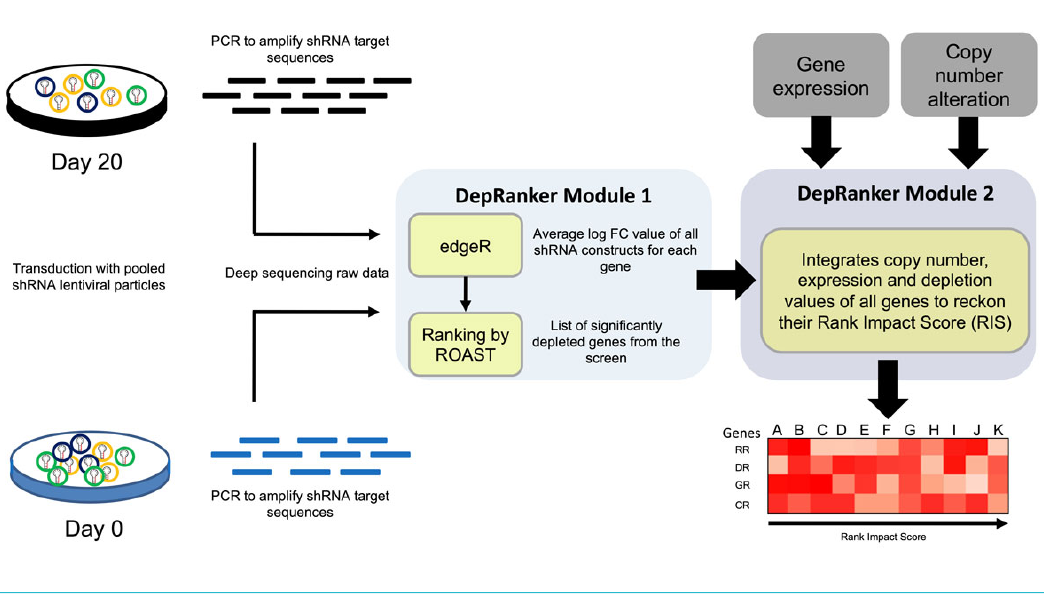
Table S1: Primary and secondary PCR primer sequences.